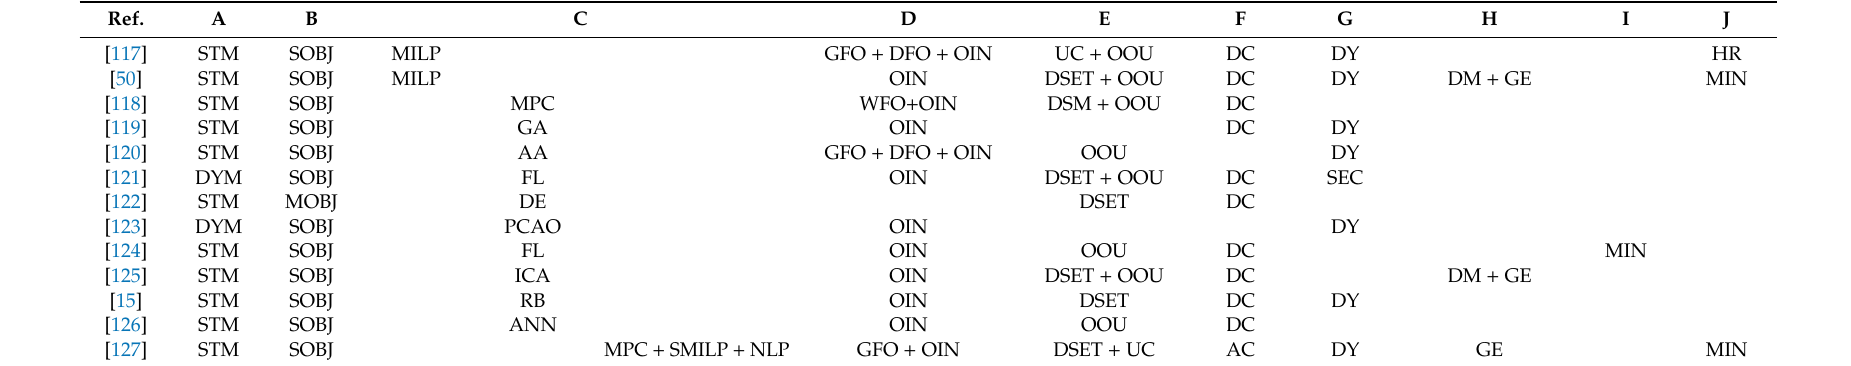
Table A7. Papers published in